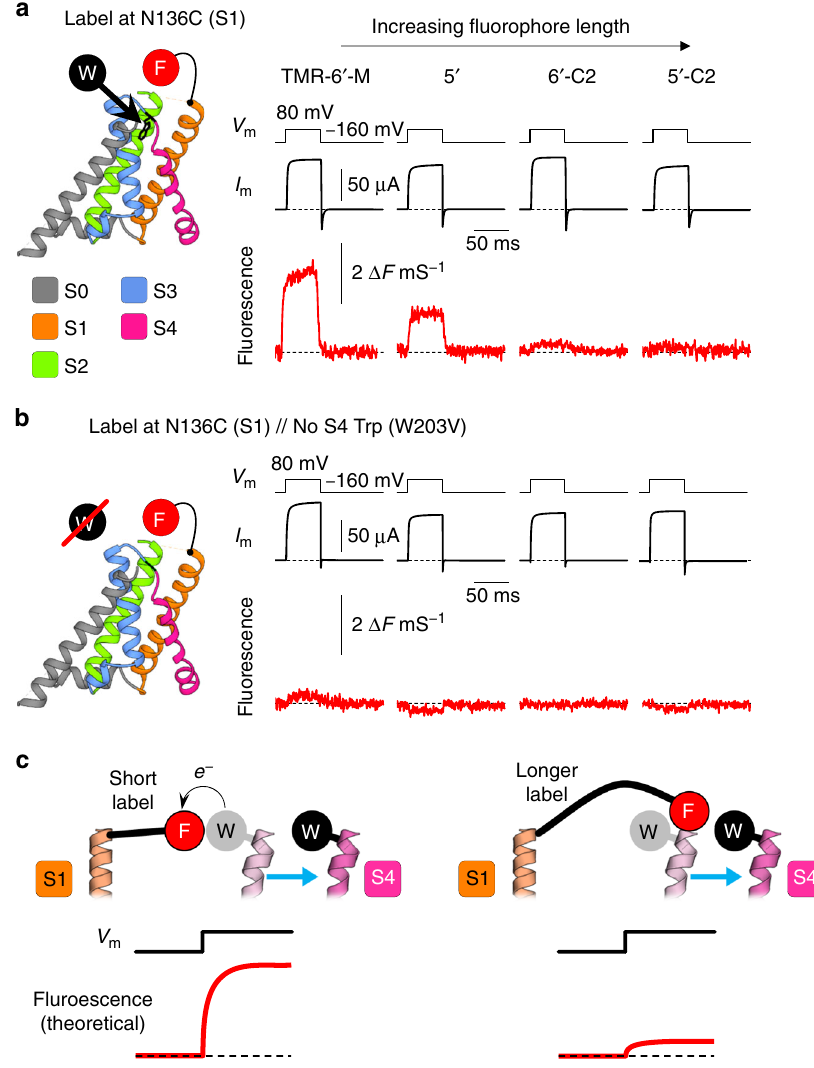
Fig. 2 DEPET measurements in conducting, human BK channels. a Simultaneously-acquired K + current (black) and fl uorescence (red) from oocytes expressing human BK channels fl uorescently-labeled outside helix S1 (position 136) with different TMRM fl uorophores, upon a 50-ms voltage pulse from − 160 to + 80 mV. Note that increasing fl uorophore length, results in diminished amplitude of fl uorescence de fl ections ( Δ F ). b As above, when the native Trp extracellular to S4 in removed (W203V), Δ F is strongly diminished for the four shortest fl uorophores, demonstrating that the fl uorescence changes in W203 channels were due to the differential quenching of S2-bound TMRM fl uorophores by the S4 Trp. All data for this experiment are shown in Supplementary Figure 3g. c A structural interpretation of the fl uorescent signals: Left: when the BK voltage-sensing domain is in the resting state, the S4 Trp is near helix S1, quenching the fl uorescent label attached to it; upon depolarization, S4 moves away, beyond the reach of the short S1 label: this molecular rearrangement is reported as fl uorescence unquenching. Right: when a longer label is attached to S1, it is equally quenched by the S4 Trp in both Resting and Active conformations, so the same movement (S4 helix divergence from S1) is reported as a much fainter fl uorescence de fl during its voltage-dependent activation transition, albeit less than S1 and S2, from ~17 to ~19 Å. Resampling statistics (boot- strapping 37 ) were used to convert experimental variability into a con fi dence interval for the fi t solutions. The DEPET-resolved distances in the human BK channel VSD are compared to homologous positions in the cryo-EM-resolved Aplysia BK channel in Supplementary Table 3.